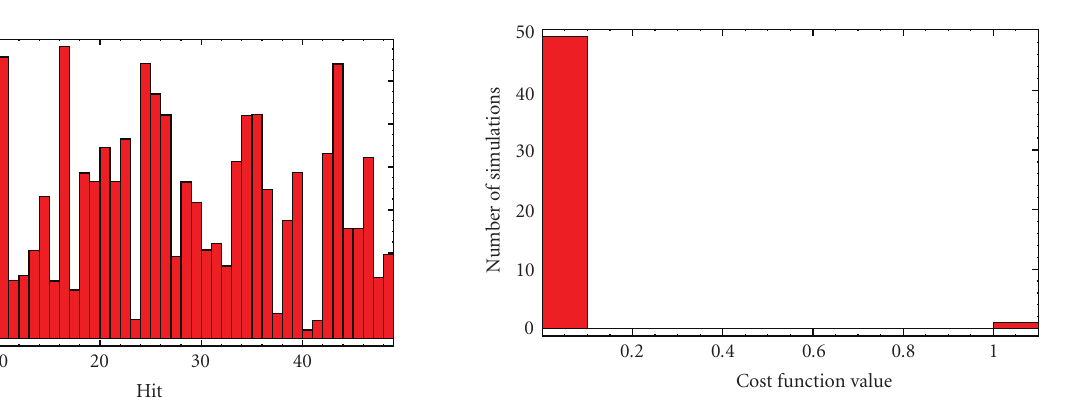
Figure 7: Histogram of DE algorithm.